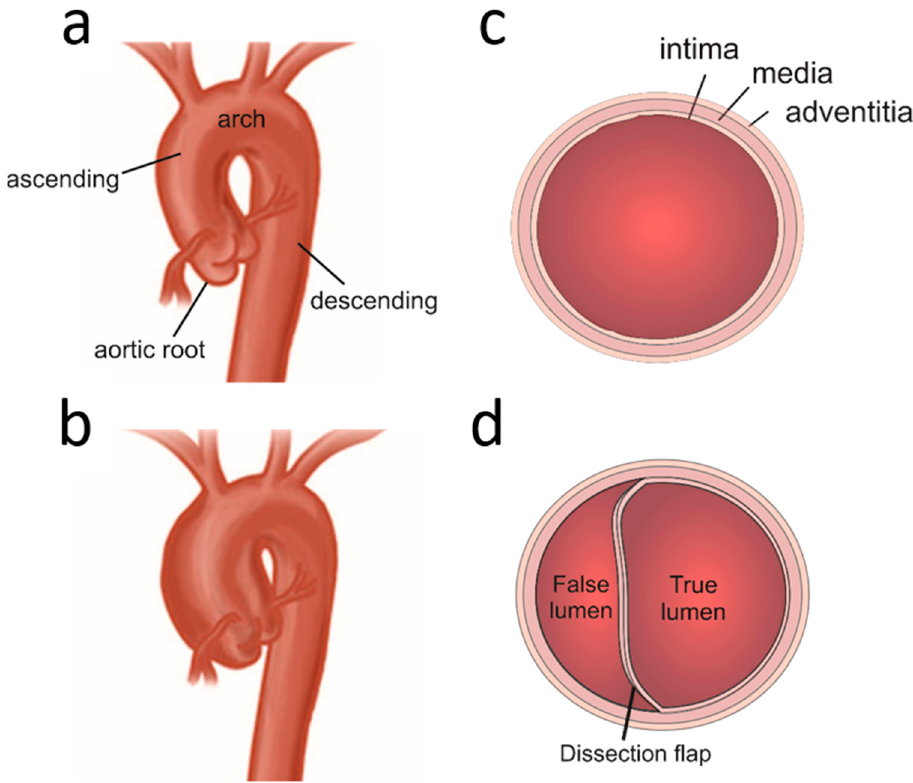
Figure 1. Thoracic Aortic Aneurysm and Dissection. ( a ) Normal thoracic aorta displaying the root, arch and descending thoracic aorta. ( b ) Depiction of an aneurysm in the ascending thoracic aorta showing dilatation of the aortic wall. ( c ) Cross-sectional image of the aortic wall showing the three layers of the wall; intima, media and adventitia. ( d ) Cross-sectional image of an aortic dissection represented by an intimal tear leading to accumulation of blood in the subintimal space, gradually expanding the false lumen created by the tear and generating a dissection flap.